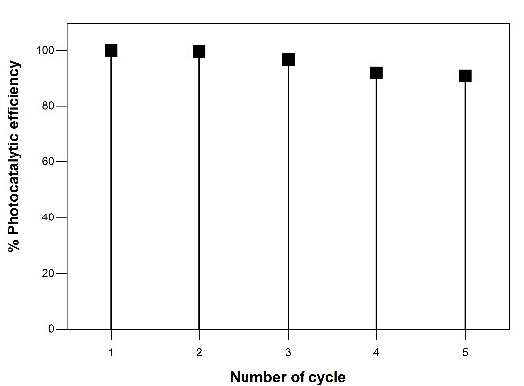
Figure 13. Reusability of photocatalytic degradation for MO using Gd 2 O 3 nanoparticles as a catalyst.